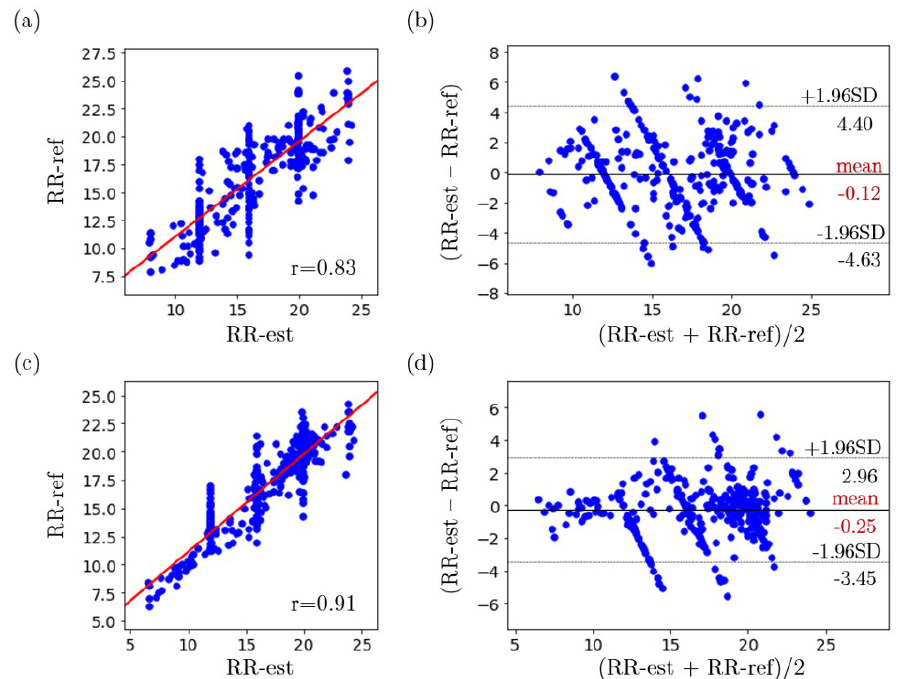
Figure 14. ( a ) Correlation plot of the estimated RR and reference RR for experiments when subjects were not wearing face masks, ( b ) Bland–Altman plot of the estimated RR and reference RR for experiments when subjects were not wearing face masks, ( c ) Correlation plot of the estimated RR and reference RR for experiments when subjects were wearing face masks, ( d ) Bland–Altman plot of the estimated RR and reference RR for experiments when subjects were wearing face